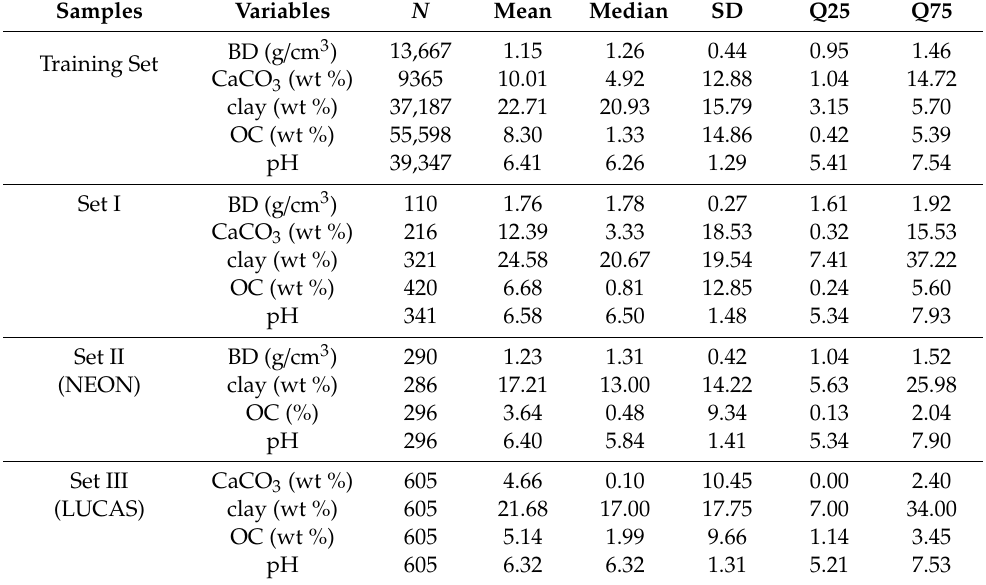
Table 1. Summary statistics of training set used to apply all three modeling algorithms, transfer sets (I) used to develop calibration transfer and independent prediction sets (II and III) used for predicting di ff erent soil properties.